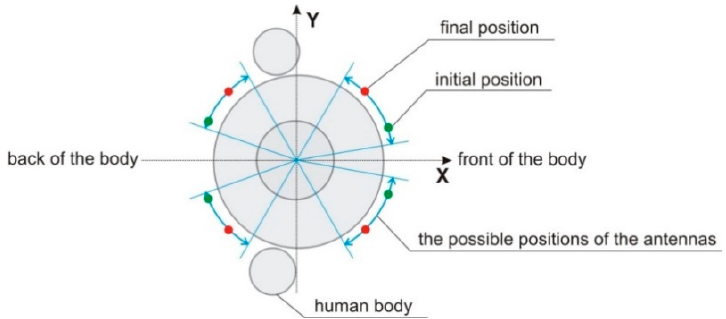
Figure 15. Elementary-antenna placement optimization. The initial and optimized (final) positions are shown.